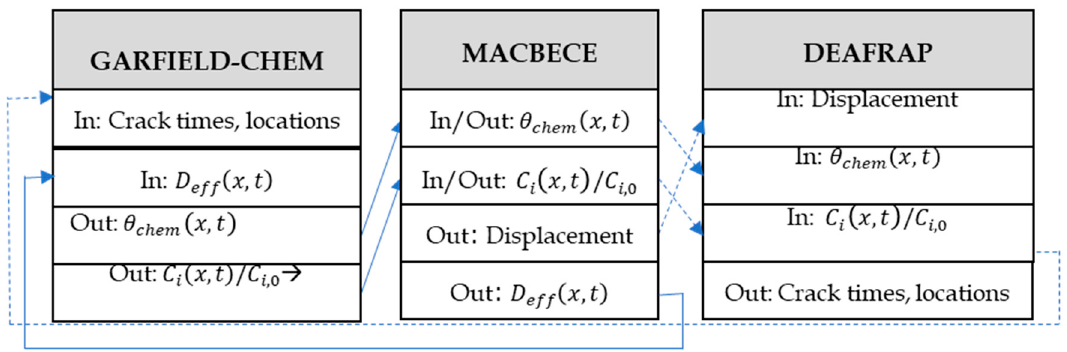
Figure 1. Information exchanges between the models. ‘In’ denotes key input data, ‘Out’ denotes key output data. Solid and dashed blue lines indicate the tightly and loosely coupled data exchanges respectively.